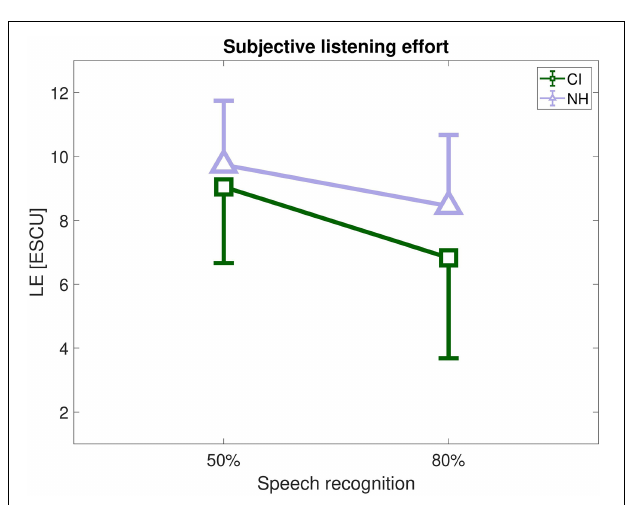
FIGURE 3 | Listening effort (LE) in CI recipients (green) and NH listeners (violet) at SNRs associated with 50 and 80% speech recognition. ESCU = Effort Scaling Categorical